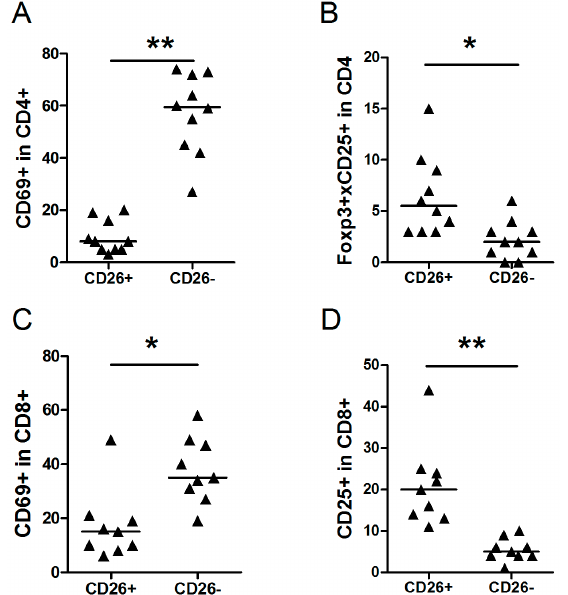
Figure 2. Comparison of cell populations in CD26+ and CD26- cells in NLPHL cases. Median percentage of each group and significant changes according to p -value (0.001 < * < 0.01, ** <0.001) are indicated in each graph. ( A ) CD69+ in CD4+ cells; ( B ) Foxp3+CD25+ in CD4+ cells CD4+; ( C ) CD69+ in CD8+ cells; and ( D ) CD25+ in CD8+ cells. Table 2. Comparison of median percentages of CD26+ and CD26- cell populations in NLPHL.